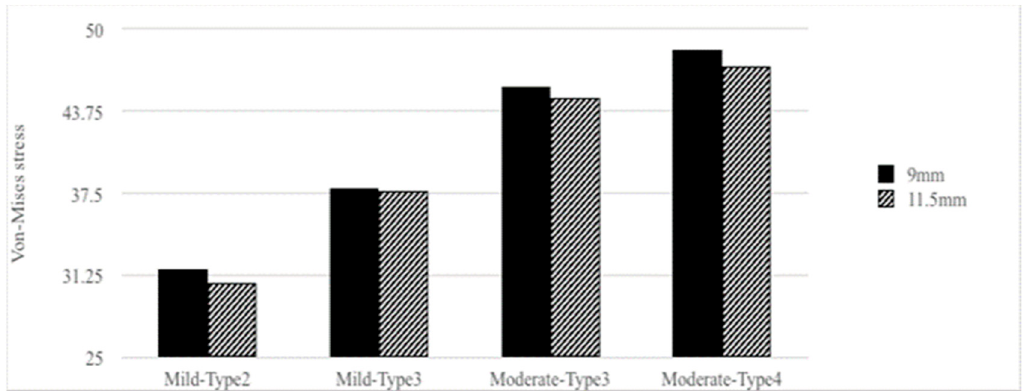
Figure 6. Peak values of von-Mises stresses in the cortical bone in loading condition B